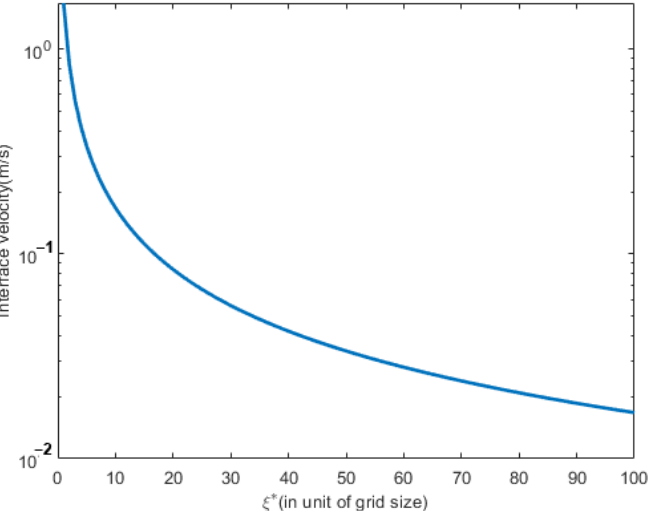
Figure 5. Variation of interface velocity calculated neglecting kinetic effect as a function of 𝜉 ∗ .